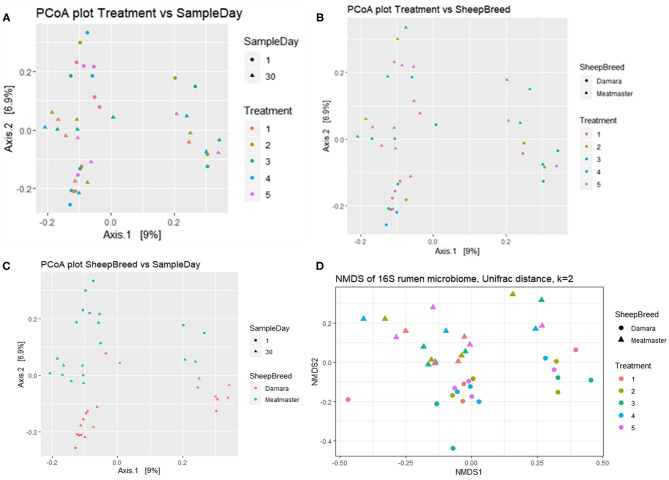
Beta diversity of rumen microbiome of Damara and Meatmaster sheep breeds. Treatment groups are as follows: 1. Diet with no antibiotics, no probiotics (negative control); 2. Diet with no antibiotics, only Lactobacillus rhamnosus PT9; 3. Diet with no antibiotics, only Lactobacillus rhamnosus PT10; 4. Diet with the combination of Lactobacillus rhamnosus PT9 and Lactobacillus rhamnosus PT10; 5. Diet with antibiotics, no probiotics (positive control). (A) Principal coordinate analysis (PCoA) defining the relationship between samples based on treatment and sample day. (B) PCoA defining the relationship between samples based on treatment and breed. (C) PCoA defining the relationship between samples based on sample day and breed. (D) Non-metric multidimensional scaling (NMDS) analysis based on the Bray-Curtis similarity index.